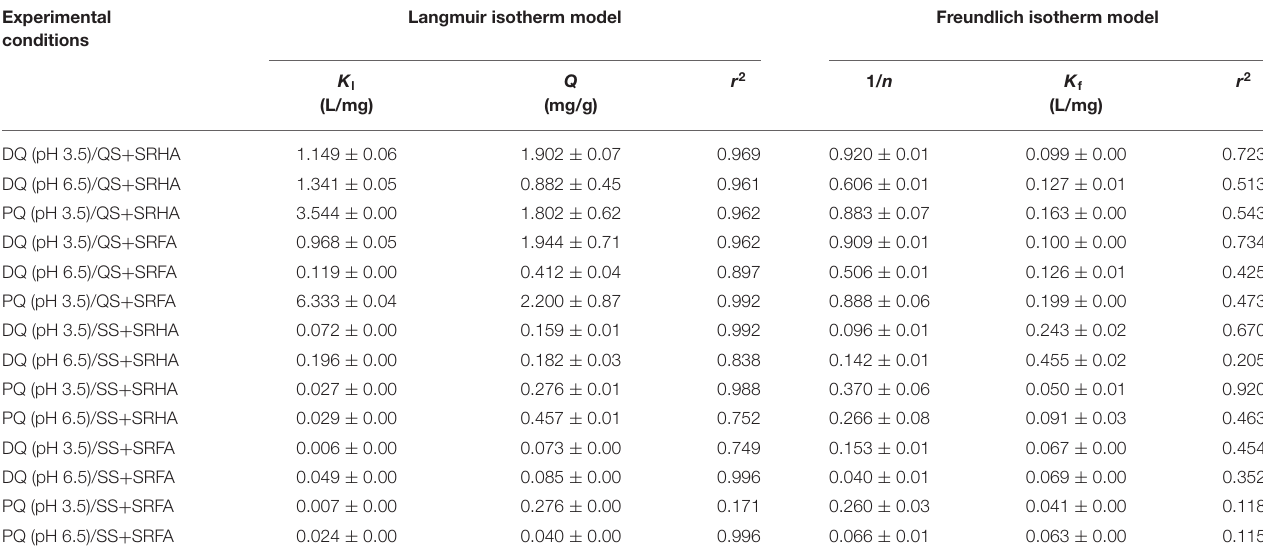
TABLE 2 | Calculated Langmuir and Freundlich isotherm adsorption parameters for PQ and DQ adsorption on quartz sand (QS) and silanized sand (SS) pre-coated with model NOM molecules: SRHA and SRFA. Experimental